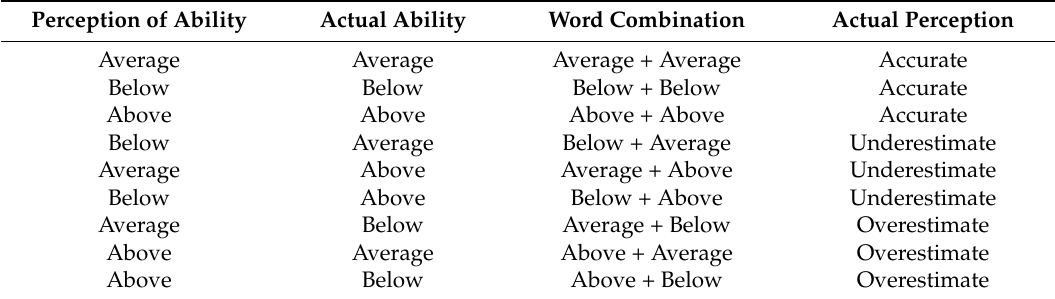
Table 4. Combining children’s perception of ability and actual ability categorizations.